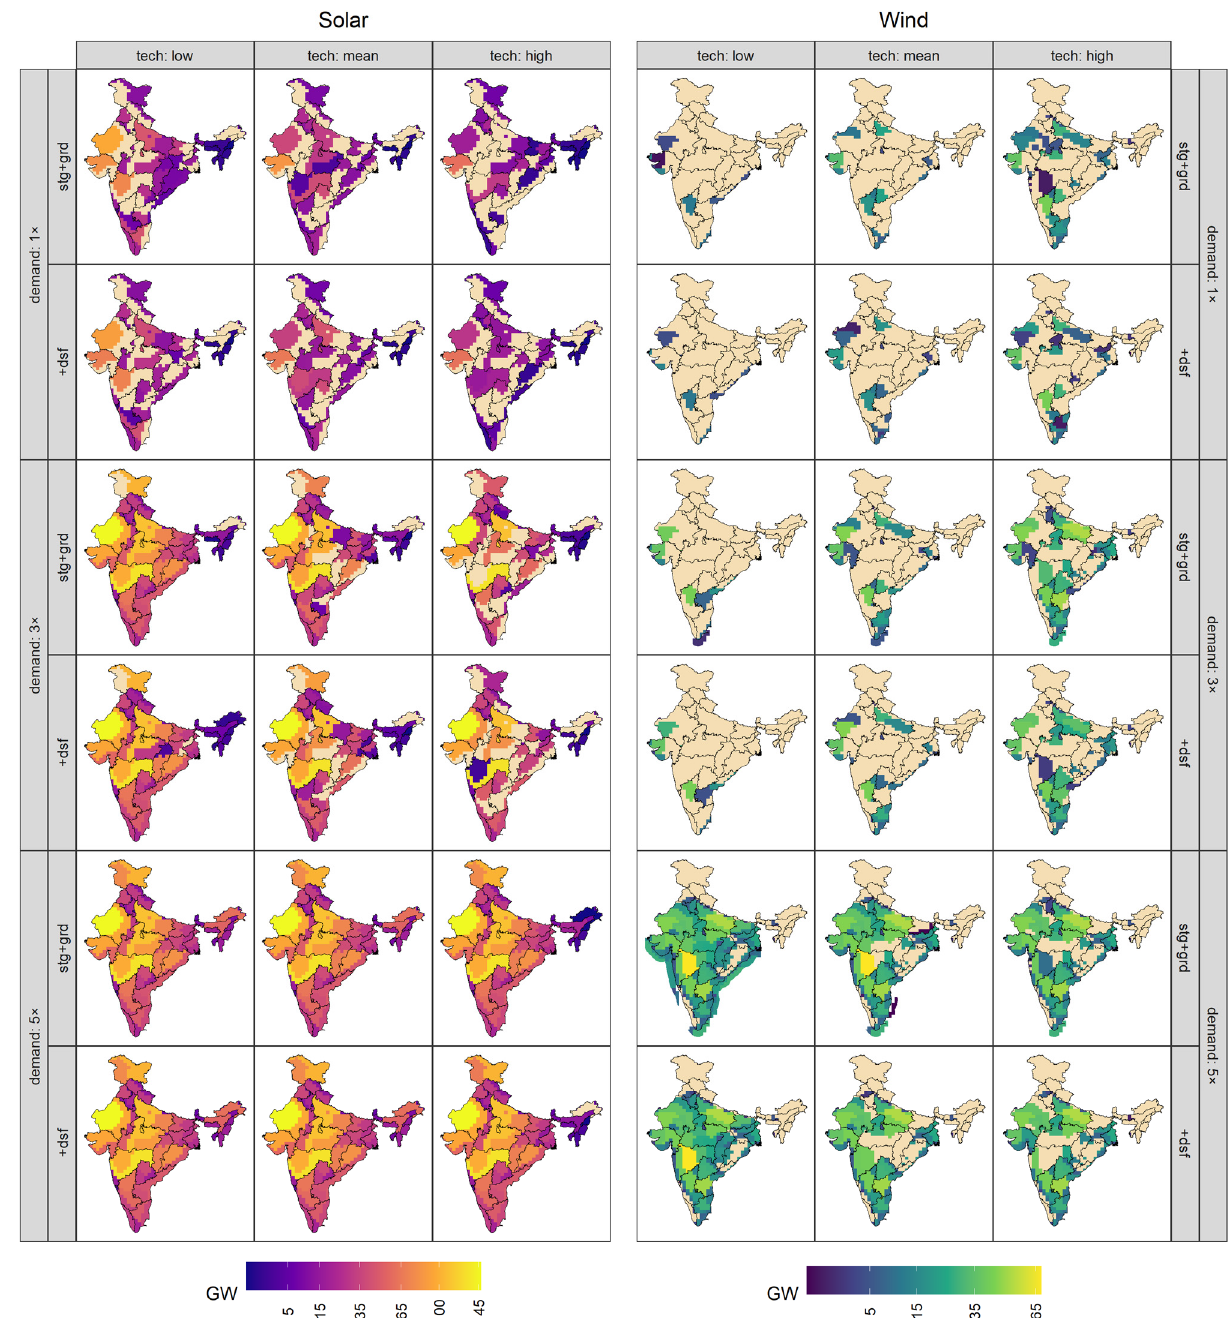
Figure A15. Optimised solar and wind generation capacity by clusters in scenarios without and with responsive demand option (‘stg+grd’ and ‘+dsf’, respectively).